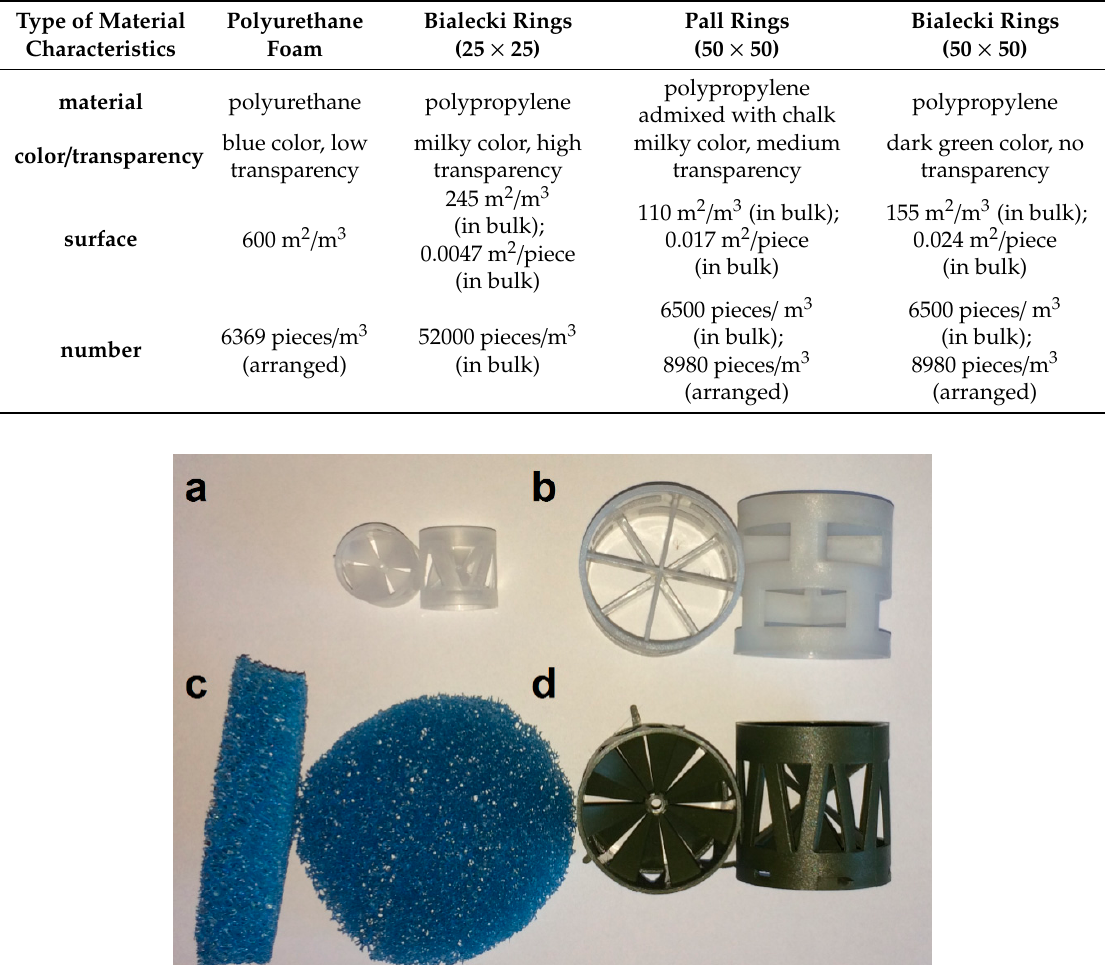
Table 2. Characteristics of investigated materials used for immobilization of fungi [71].